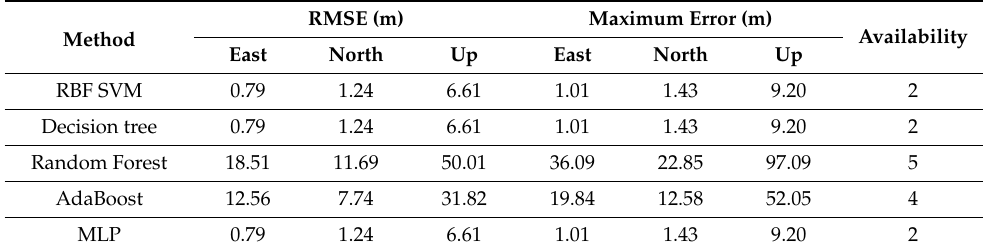
Table 6. Comparison of positioning accuracy and availability of D1b after di ff erent classifications.